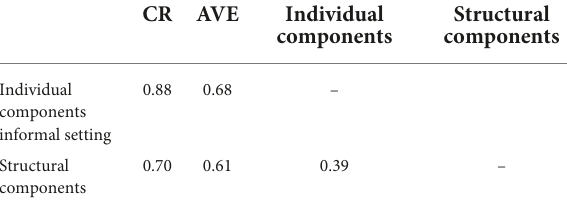
TABLE 3 Full version of the exploratory factor analysis (formal learning).